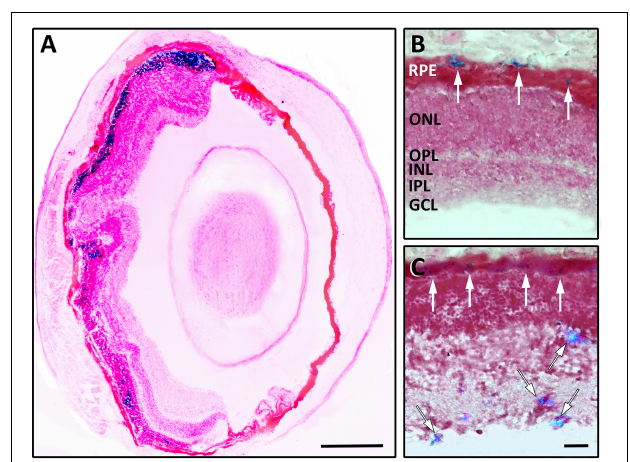
FIGURE 6 | Representative images of C57BL/6J mouse retinal sections after 8 h (A) , 24 h (B) , and 5 days (C) from an intravitreal injection of 1 µ M MNP-OCT. The Prussian blue staining identifies the localization of MNP-OCT in the RPE (white arrows in B , C ) and at different levels in the inner retina (black-lined arrows in C ). Pararosaniline counterstain. Scale bars, 200 µ m in (A) , 30 µ m in (C) . Retinal layer abbreviations as in Figure 4